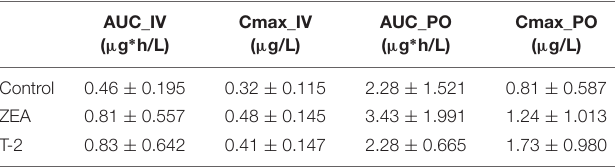
TABLE 4 | AUC and Cmax values for OH-MDZ after IV and PO administration of